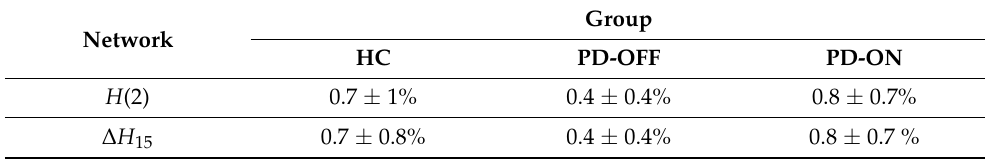
Table 2. Percentage of connections at the subject level (mean ± standard deviation) that passed all multifractality assessment tests. HC: healthy control, PD-OFF: Parkinson’s disease patients off medication, PD-ON: Parkinson’s disease patients on